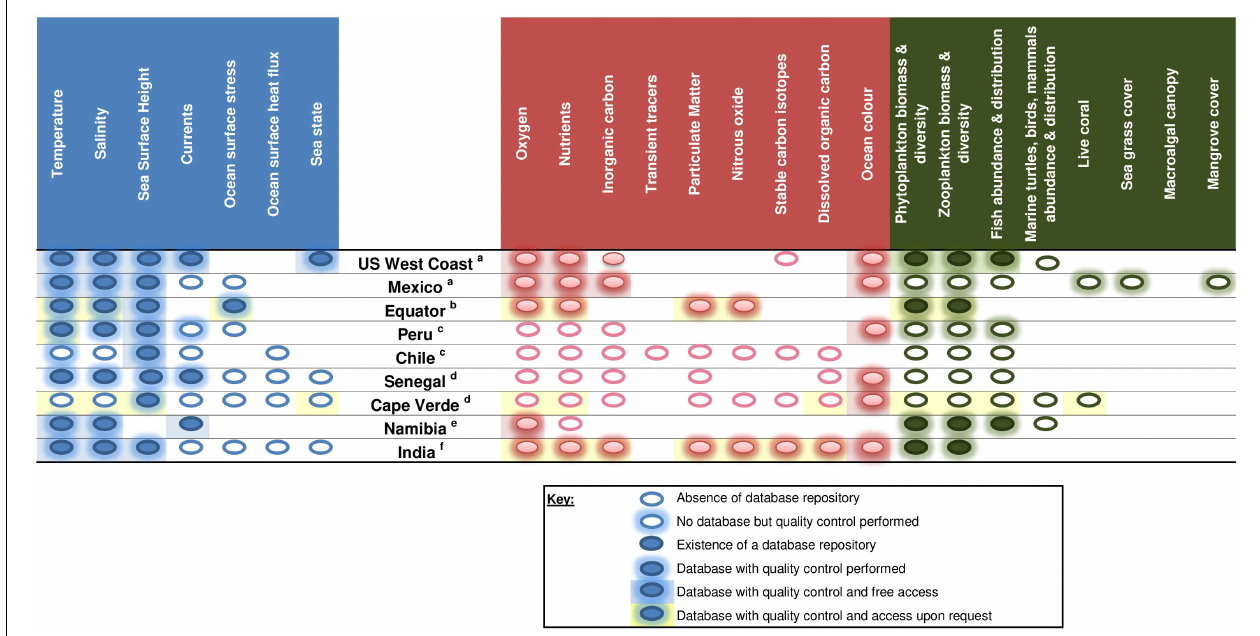
Frontiers in Marine Science |